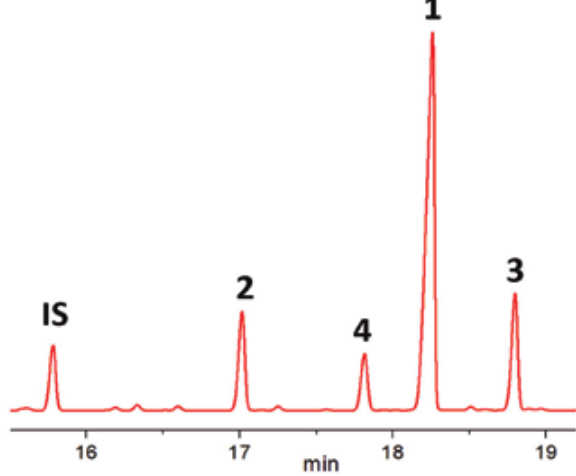
Figure 3. GC-FID chromatogram of TMS derivatives of α-pinene HPs obtained from the reaction of α-pinene with singlet oxygen: Cumene-hydroperoxide ( IS , 15.8 min), 4-Hydroperoxy-4,6,6-tri- methylbicyclo[3.1.1]hept-2-ene ( 2 , 17.0 min), verbenyl-hydroper- oxide ( 4 , 17.8 min), pinocarvyl-hydroperoxide ( 1 , 18.3 min) and myrtenyl-hydroperoxide ( 3 , 18.8 min). Retention times are given in